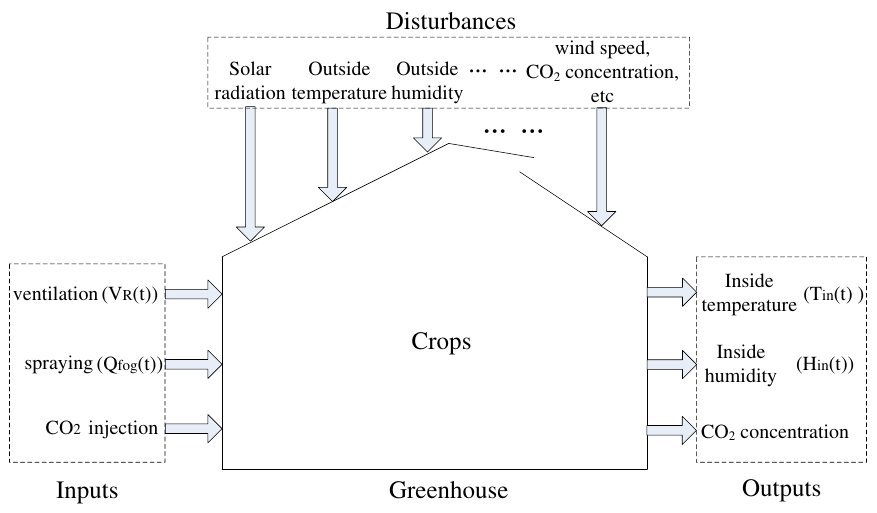
Figure 1. Greenhouse climate dynamic